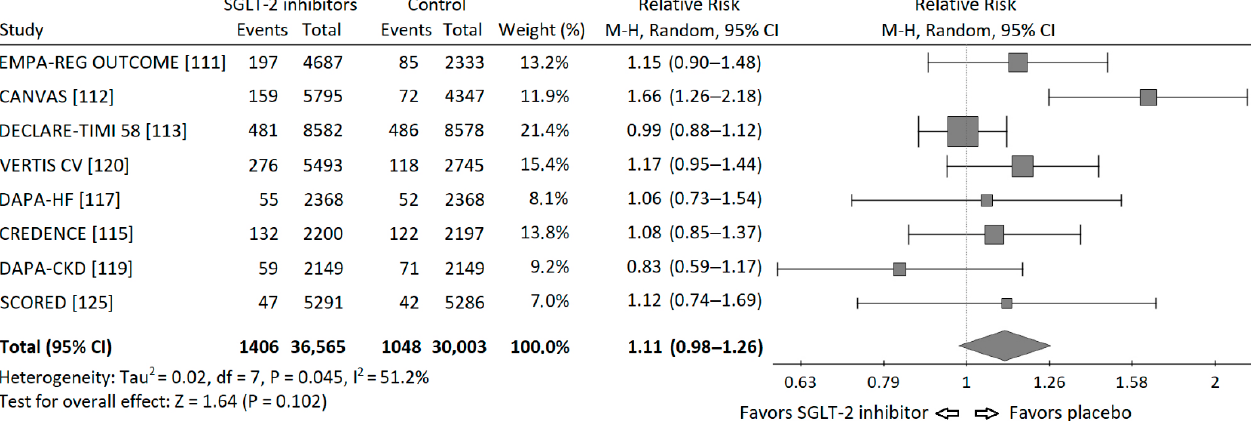
Figure 3. Forest plot of meta-analysis of the risk of neoplasms incidence for SGLT-2 inhibitors vs. placebo in cardiovascular and renal outcome trials. The size of the square box is proportional to the weight that each study contributes in the meta-analysis. The overall estimate and CI are marked by a diamond.